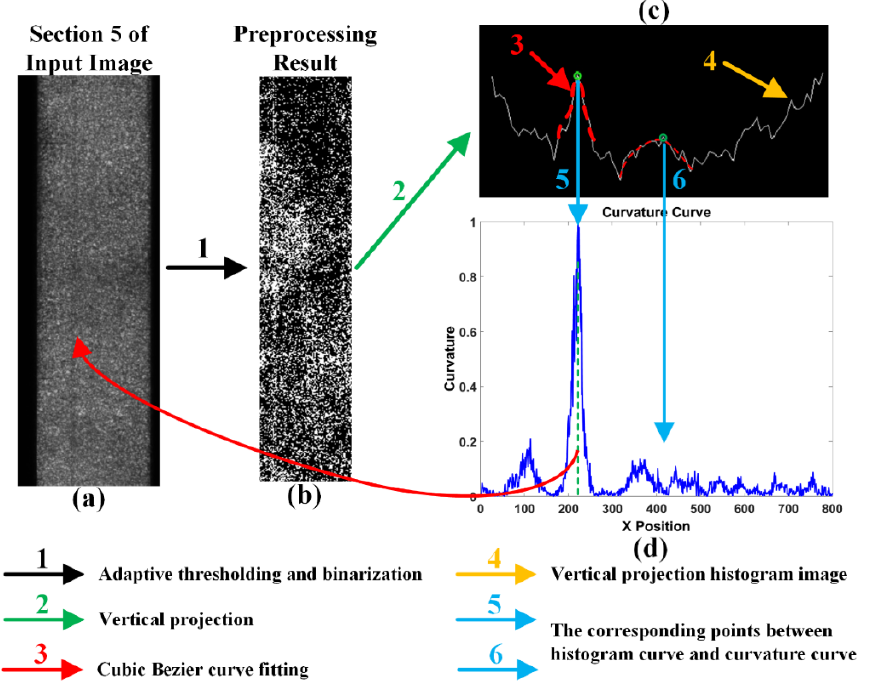
Figure 4. Overview of the proposed method. ( a ) The section 5 of input image. ( b ) The result of preprocessing. ( c ) The vertical projection histogram curve. ( d ) The curvature